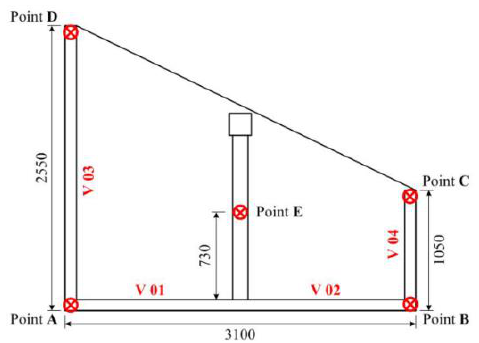
Figure 5. Response sampling points on each floor (unit: mm).